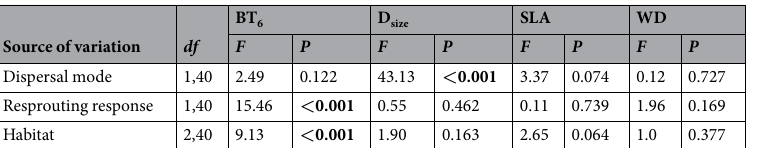
Table 3. Restricted maximum likelihood linear (REML) mixed model analysis results for bark thickness (BT 6 ), diaspore size (D size ), specific leaf area (SLA) and wood density (WD) with dispersal mode, resprouting response to fire and the habitat in which species were recorded as fixed effects. Bold type indicates significant effect at P <